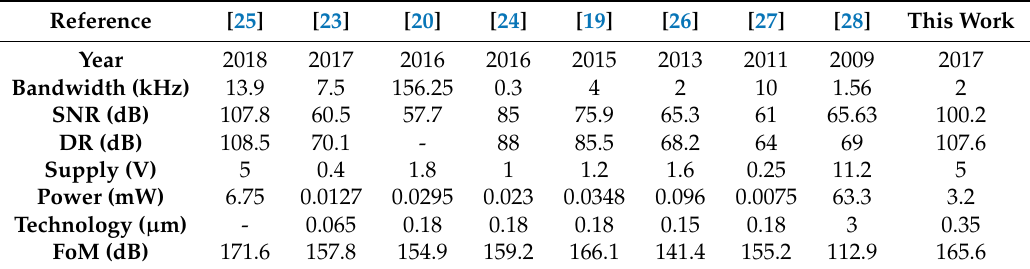
Table 4. Performance summary and